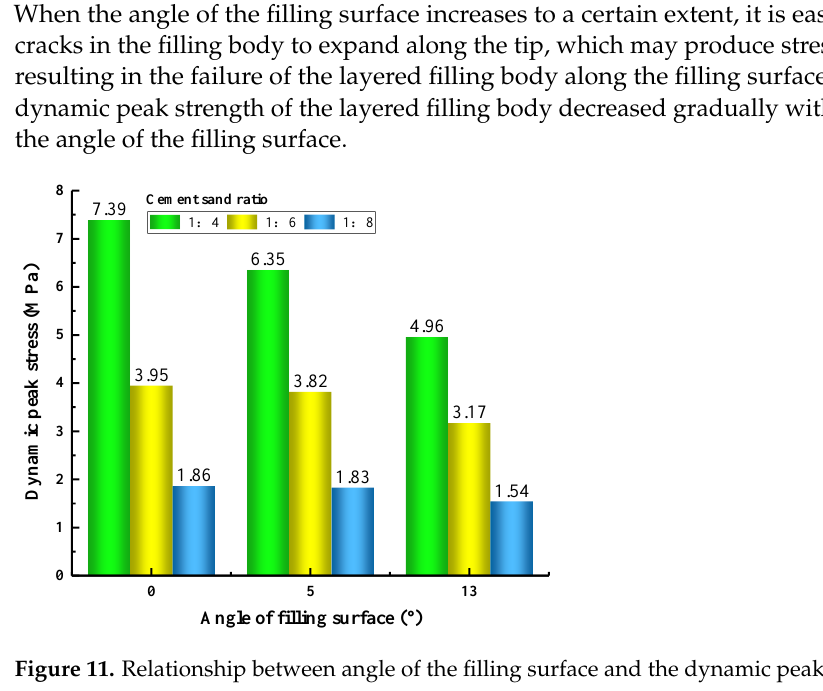
9 of 17 Figure 10. Relationship between dynamic strength growth factor and average strain rate. 3.4. Influence of Angle of Filling Surface on Dynamic Characteristics of Filling Body As shown in Figure 11, when the approximate strain rate was 41 s −1 (as the accurate strain rate of the filling body was uncontrollable, the approximate strain rate was adopted), the dynamic peak strength of the layered filling body with the cement – sand